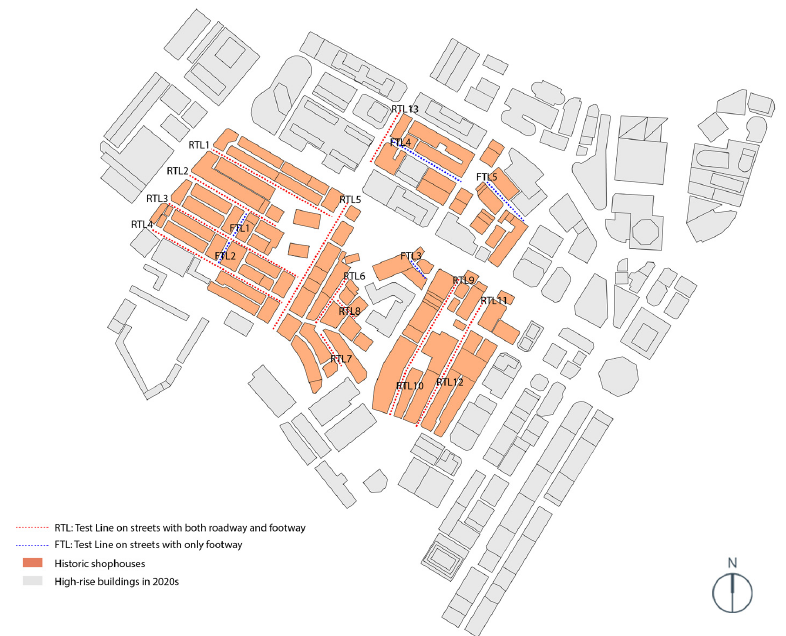
Figure 7. Locations of test lines for data analysis (RTL represents the test line on streets with both roadway and footway and FTL represents the test line on streets with only footway.).